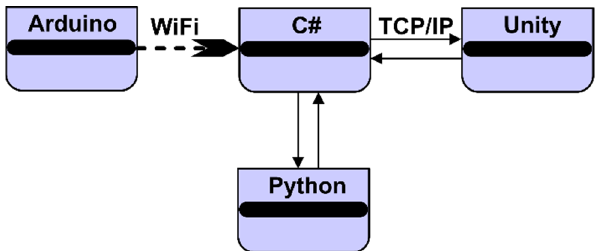
Figure 8. Software architecture.